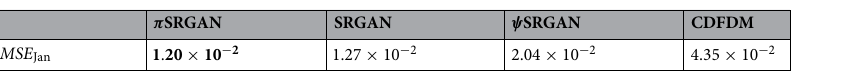
Table 4. Average MSE of the correlation coefficients. Significant values are in